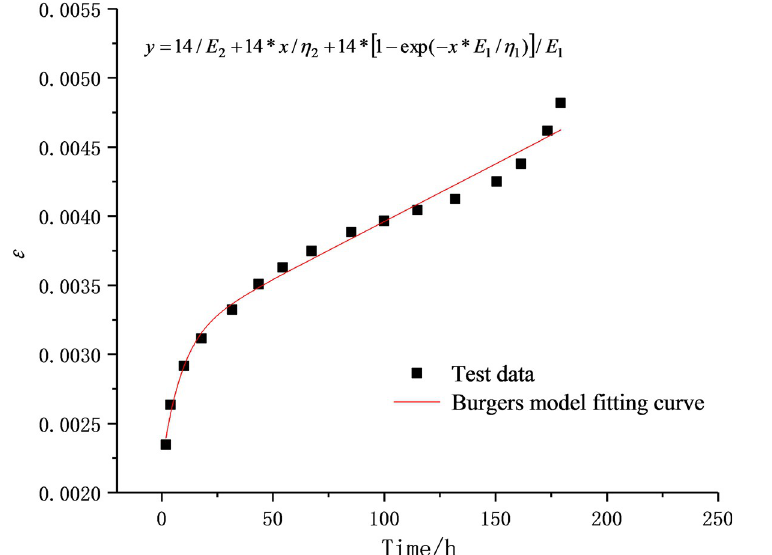
Fig 12. Fitting curve of Burgers